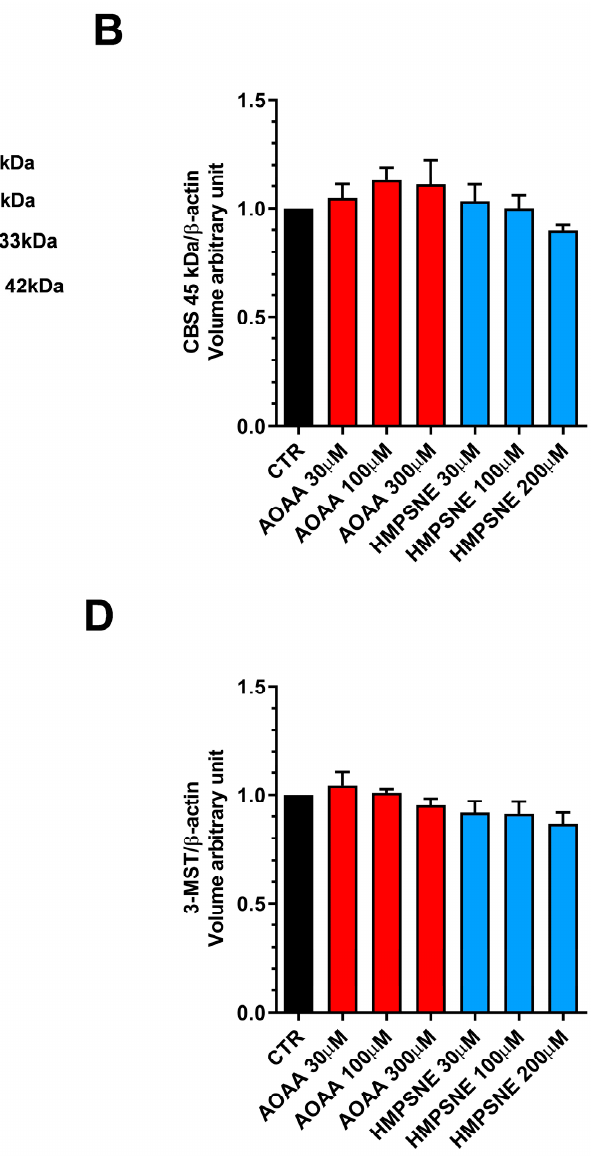
Figure 2. Expression profile of the H 2 S-synthesizing enzymes (CBS, CSE, and 3-MST) in EO771 cells. Expression levels were analyzed by Western blotting. Representative Western blot images of EO771 treated with different concentrations of AOAA or HMPSNE for 48 h and corresponding densitometry analysis ( A – D ). β -Actin was used as loading control. N = 3 independent experiments ± SEM. Using live cell imaging (with the utilization of AzMC, a fluorescent H 2 S dye) significant H 2 S generation was detectable in EO771 cells (Figure